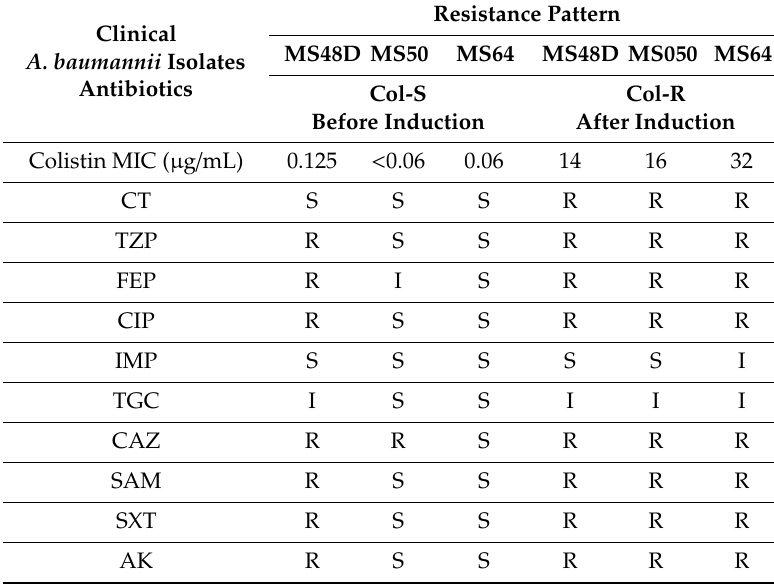
Table 2. Antibiotic susceptibility redetermination after colistin resistance induction in comparison to susceptibility before induction.